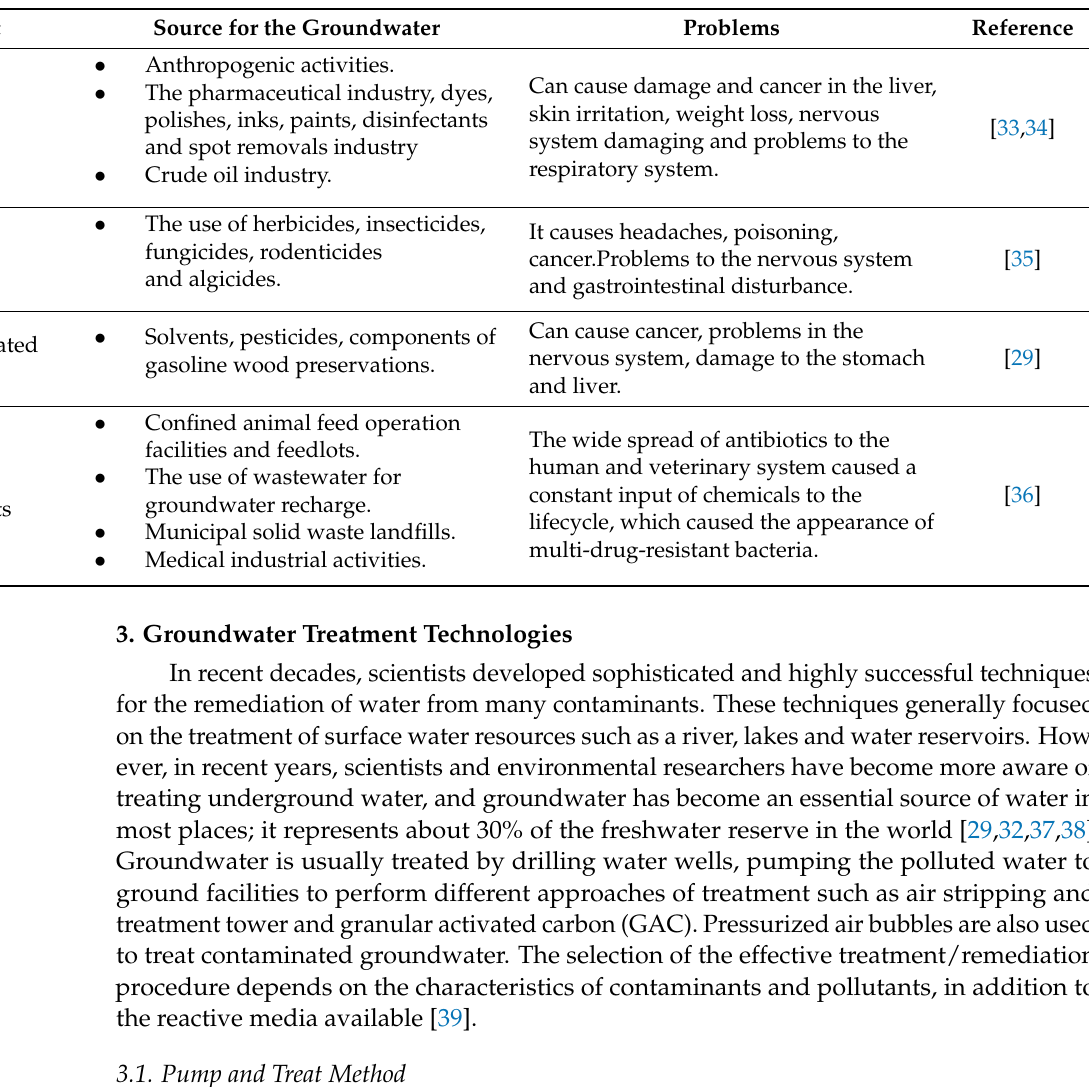
Table 2. Organic contaminants, source to groundwater and their